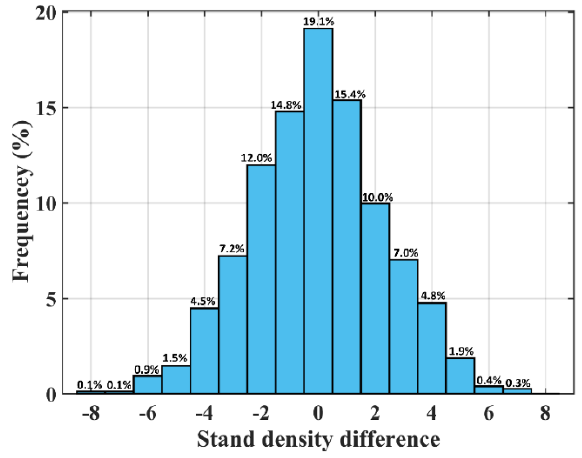
Figure 5. The CHM HFe , treetop positions, and stand density map using LiDAR data. ( a ) the CHM HFe (Csize = 0.2 m) and treetop positions (using the local maximum method and marked by the black dots); ( b ) Aerial photographs and treetop positions (same as a and marked by the yellow dots). The range of a , b is marked in Figure 1a with a red dotted line; ( c ) Stand density map, which was using CHM Fe and parameters that were Csize = 0.5 m and 𝐾𝑠𝑖𝑧𝑒 = 5; ( d ) Stand density map of regression corrected, which was using CHM Le and parameters that were Csize = 0.2 m and 𝐾𝑠𝑖𝑧𝑒 = 3.